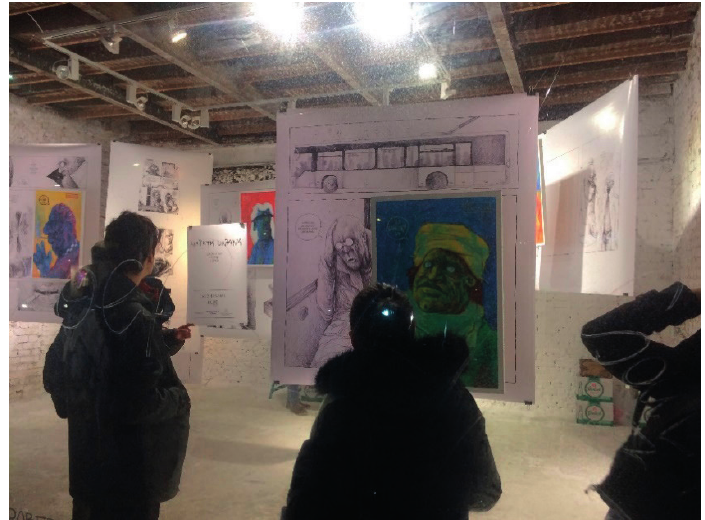
Figure 1. Art work by local artist Robert Obert from one exhibition attended by the author during the empirical phase of this paper (source: created by